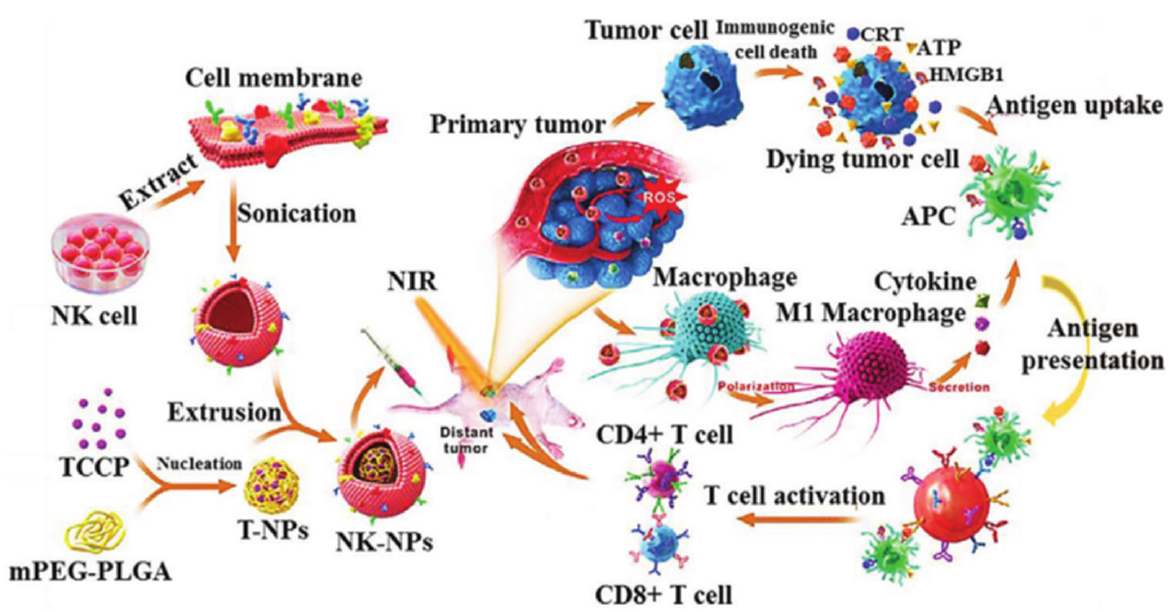
Figure 3. A schematic of the NK-cell membrane-based nanoparticles for PDT-enhanced cancer immunotherapy. Extracted NK-cell membranes were coated by extrusion onto polymeric nanoparticles loaded with the photosensitizer TCPP. The NK-cell membrane enables NK NPs to polarize M1 macrophages in tumors. NK NPs can induce the production of damps from dying tumor cells via PDT-induced immunogenic cell death (ICD) to enhance NK-cell membrane based immunotherapy. The therapy can also significantly improve the infiltration of cytotoxic T cells in tumors, resulting in highly efficient suppression of both primary and distant tumors. Reproduced with permission from ref.[44] copyright 2018 American Chemical Society.